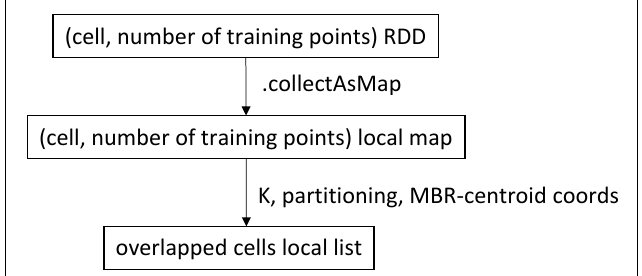
Figure 15. Discover overlapped cells (Phase